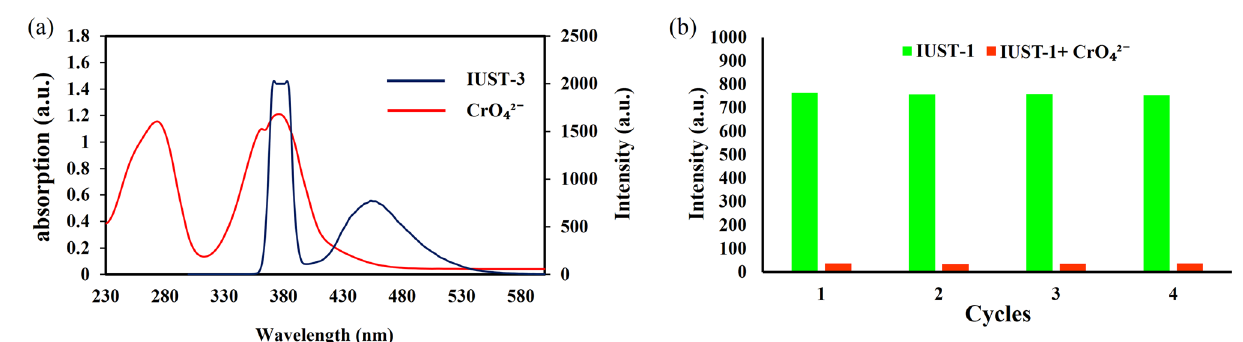
Figure 6. ( a ) Spectral overlap of absorbance spectrum of the CrO 42− anion with excitation and emission spectra of the IUST-3, ( b ) Luminescent intensity of the IUST-3 at 380 nm after four cycles for the CrO 42−